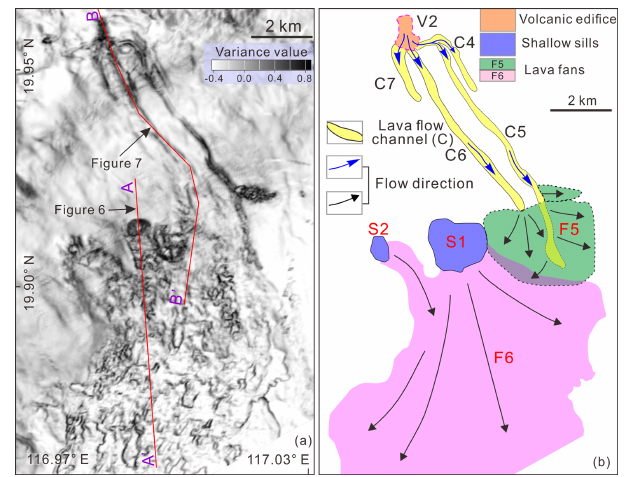
Figure 5. (a) Variance slice (extracted from the surface BM) and (b) its interpretations. Lava flows are clearly identified by their tex- ture and marked in (b) . C – lava flow channel; S – shallow sill; F – lava fan. Red lines A–A’ and B–B’ in (a) are seismic profiles shown in Figs. 6 and 7.